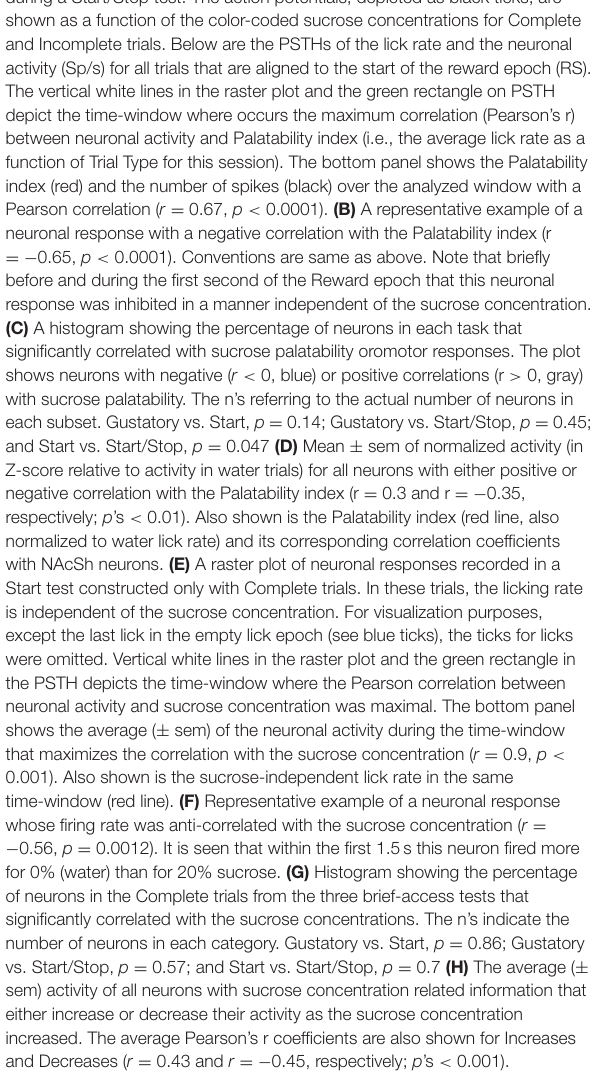
FIGURE 4 | (A) A raster plot showing a single unit NAcSh response obtained during a Start/Stop test. The action potentials, depicted as black ticks, are shown as a function of the color-coded sucrose concentrations for Complete and Incomplete trials. Below are the PSTHs of the lick rate and the neuronal activity (Sp/s) for all trials that are aligned to the start of the reward epoch (RS). The vertical white lines in the raster plot and the green rectangle on PSTH depict the time-window where occurs the maximum correlation (Pearson’s r) between neuronal activity and Palatability index (i.e., the average lick rate as a function of Trial Type for this session). The bottom panel shows the Palatability index (red) and the number of spikes (black) over the analyzed window with a Pearson correlation ( r = 0.67, p < 0.0001). (B) A representative example of a neuronal response with a negative correlation with the Palatability index